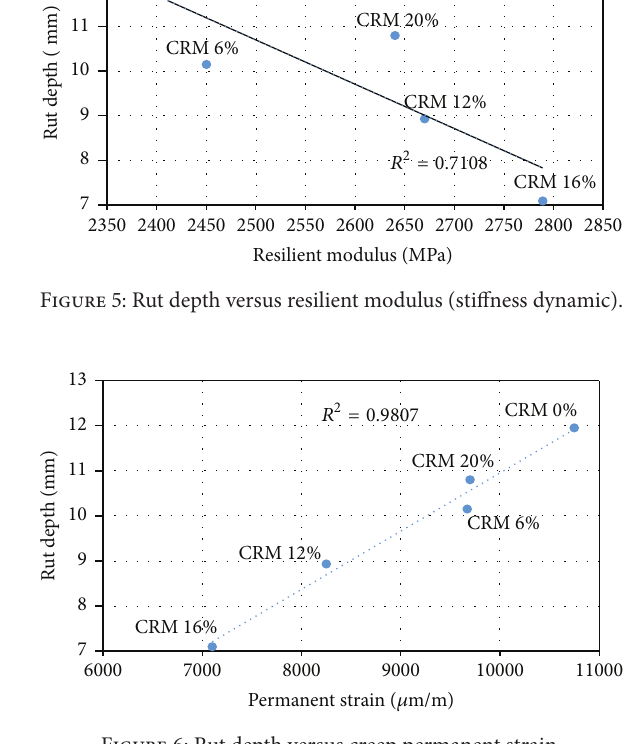
Figure 6: Rut depth versus creep permanent